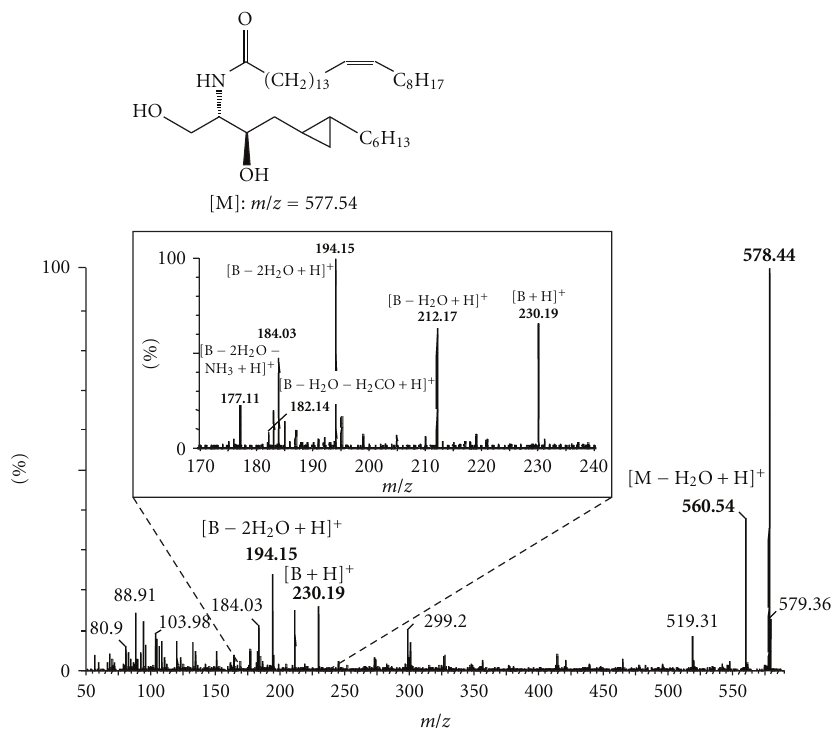
Figure 3: MS/MS spectrum of the metabolite of 1 acylated with nervonic acid (B = sphingoid